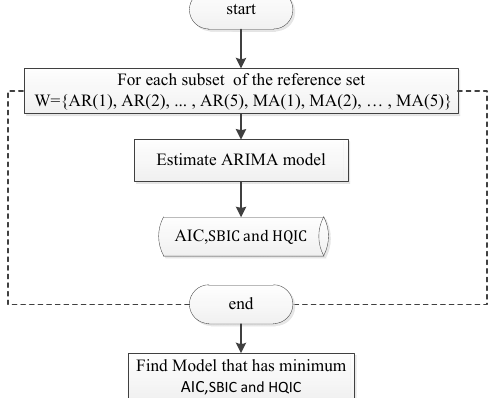
start For each subset of the reference set W={AR(1), AR(2), ... , AR(5), MA(1), MA(2), … ,